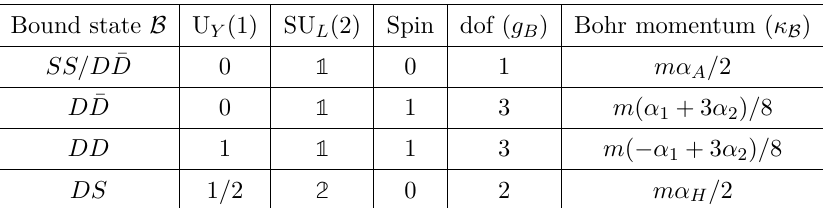
in the limit m 0 . The binding energies are |E = B H → B | ¯ ¯ D , D D and DD bound states